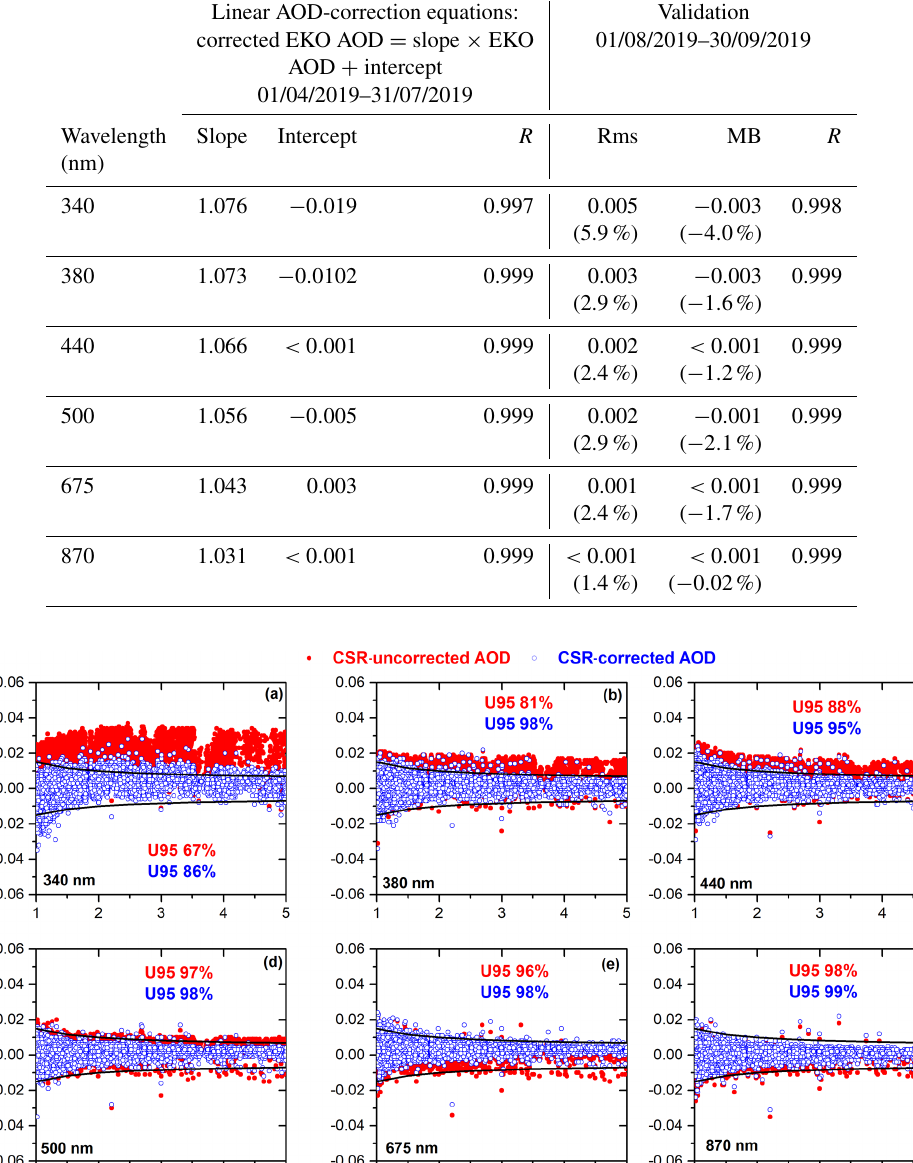
certainty ( ± 0 . 01 in the VIS and near-IR, and ± 0 . 02 in the UV